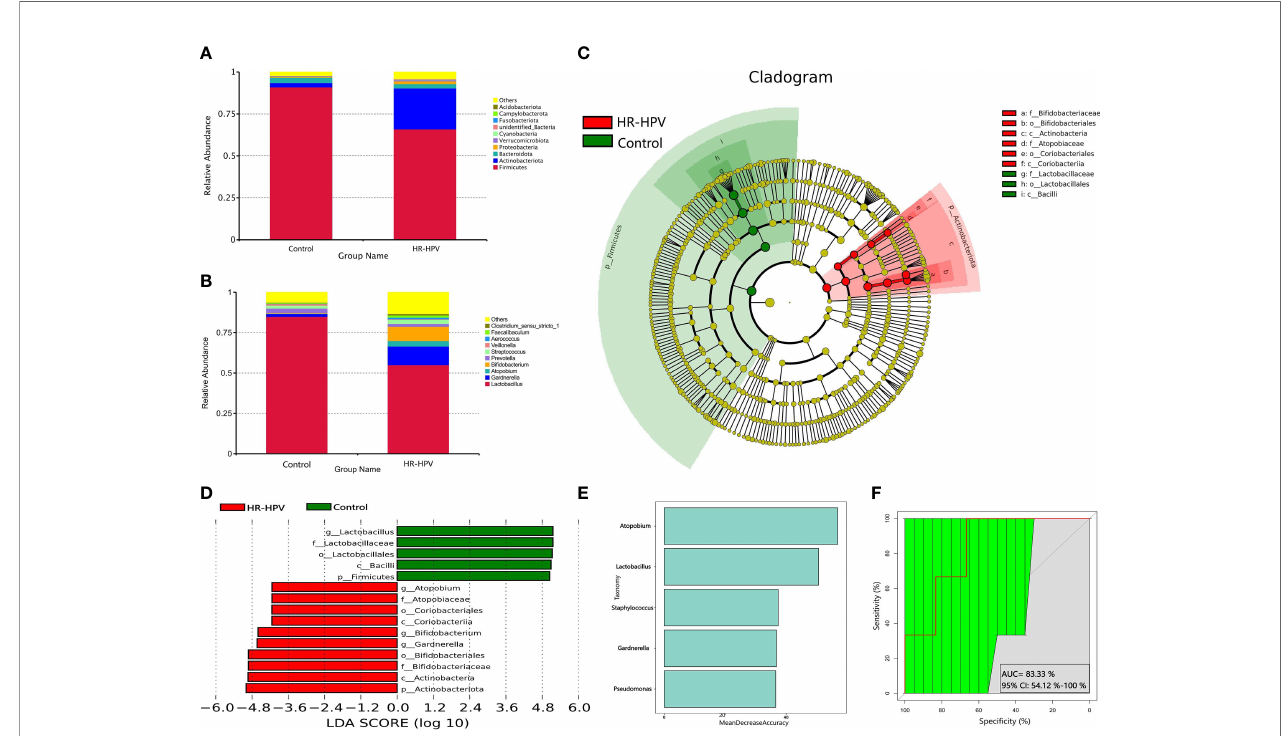
FIGURE 2 | Microbial composition based on 16S rRNA gene sequencing. (A) Relative abundance of the cervical microbiota at the phylum level. (B) Relative abundance of the cervical microbiota at the genus level. (C) LEfSe cladogram by 16S rRNA gene sequencing of the cervical microbiota in the two groups. Microbial composition was compared at different species levels, from the phylum in the outermost ring to family in the innermost ring. (D) Distribution histogram of LDA score assessed for species with biomarker signi fi cance between the HR-HPV infected and uninfected women ( P <0.05; LDA score >4). (E) The importance of species at the genus level in the predictive random forest model using the mean decreasing accuracy. (F) ROC curve generated by random forest model predicting fi ve genera in the cervical microbiota. The plots shown in the ROC represent the corresponding optimal